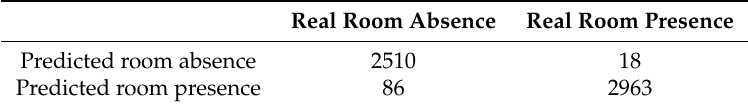
Table 2. Contingency table for the presence